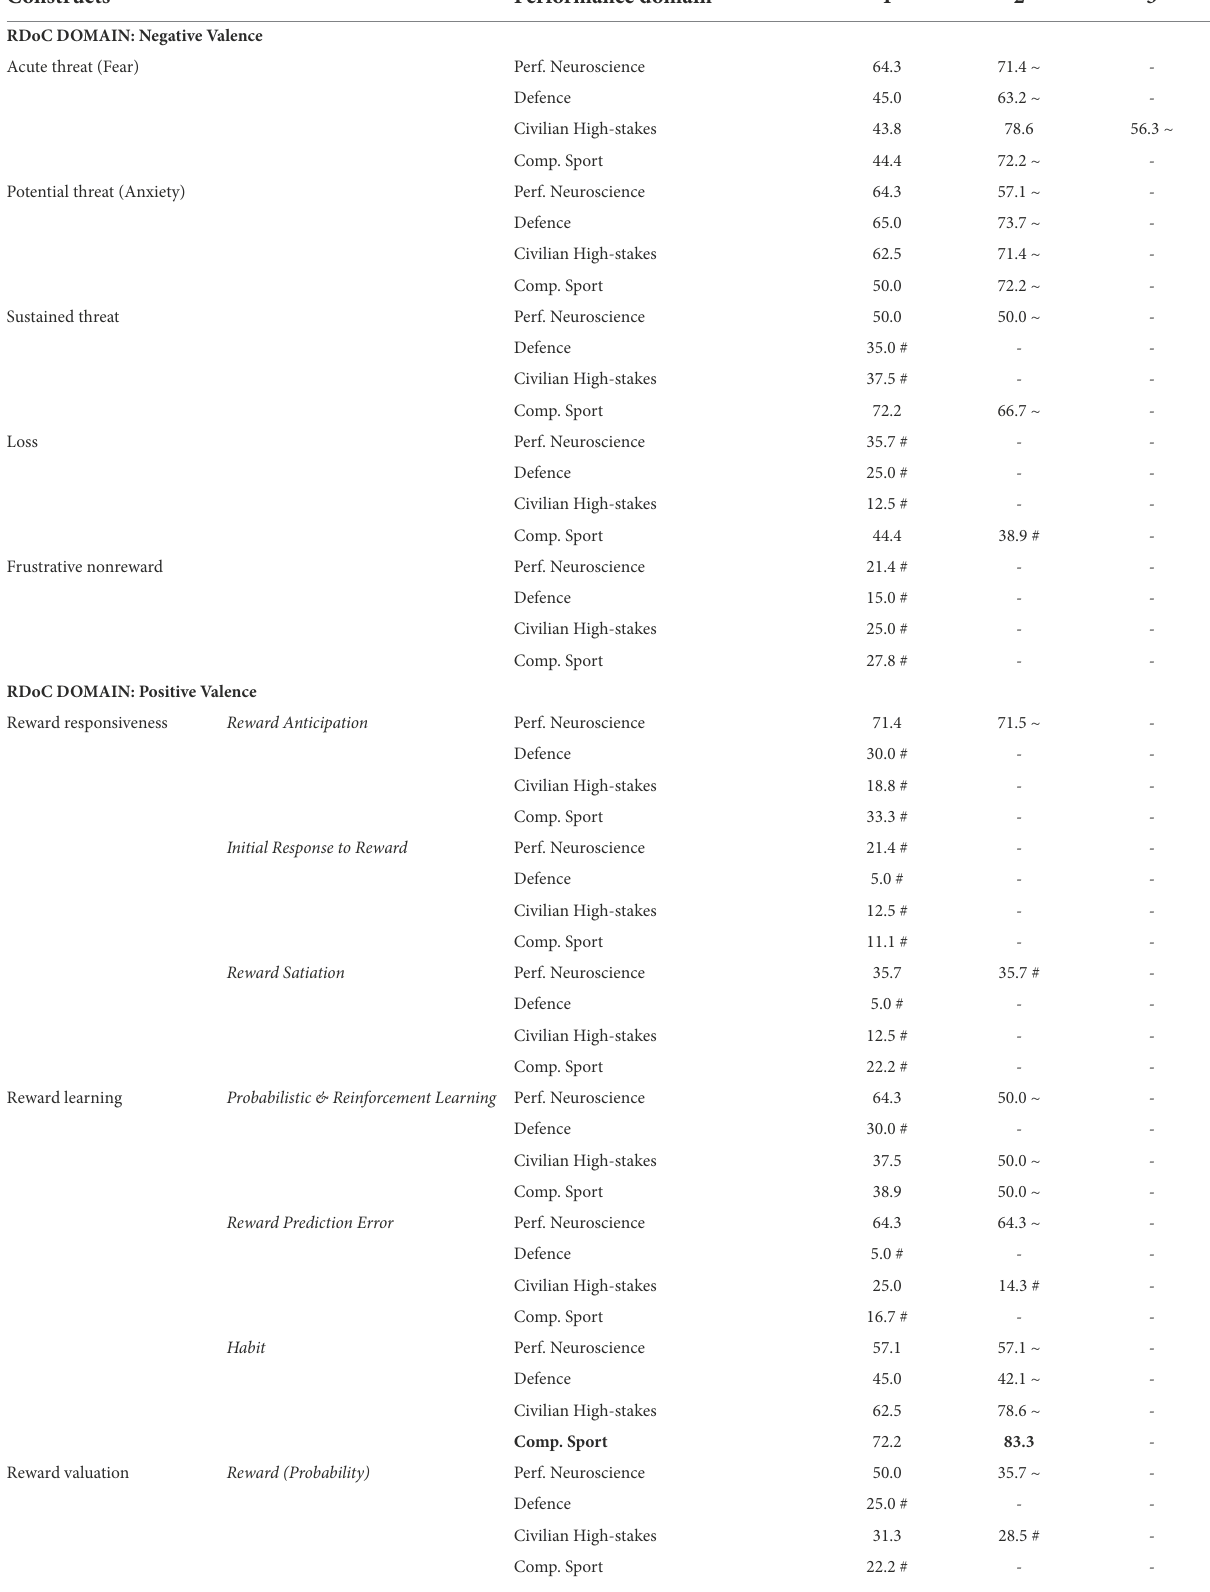
TABLE 3 All constructs, respective votes at each round, and